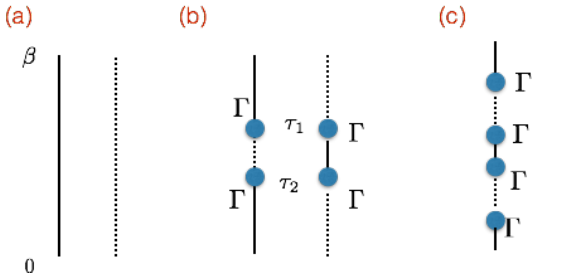
Figure 2: (a) The 0 th order contributions to the partition function of the two-level system. Spin-up worldlines are represented by a full line, spin-down worldlines by a dashed line. (b) The second order contributions, and (c) the general structure. Worldlines are periodic over the imaginary time period β